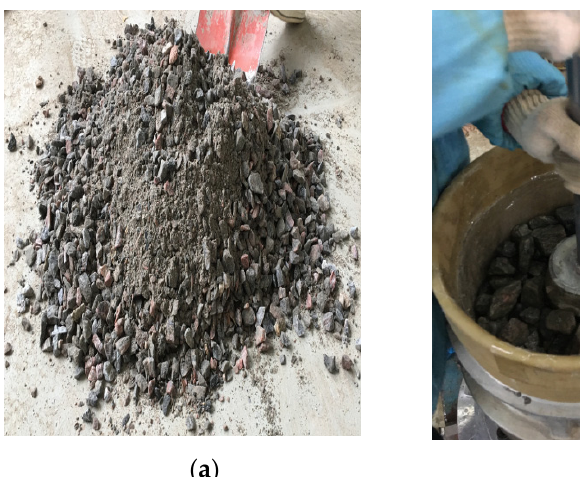
( e ) Figure 6. Geogrid and waste tyre reinforcement arrangement: ( a ) unreinforcement (UR); ( b ) upper reinforcement (BGT1/T1); ( c ) central reinforcement (BGT2/T2); ( d ) lower reinforcement (BGT3/T3); ( e ) all reinforced (BGT5/T5). Table 4. Design program for static triaxial tests. 300 m m 300 m m